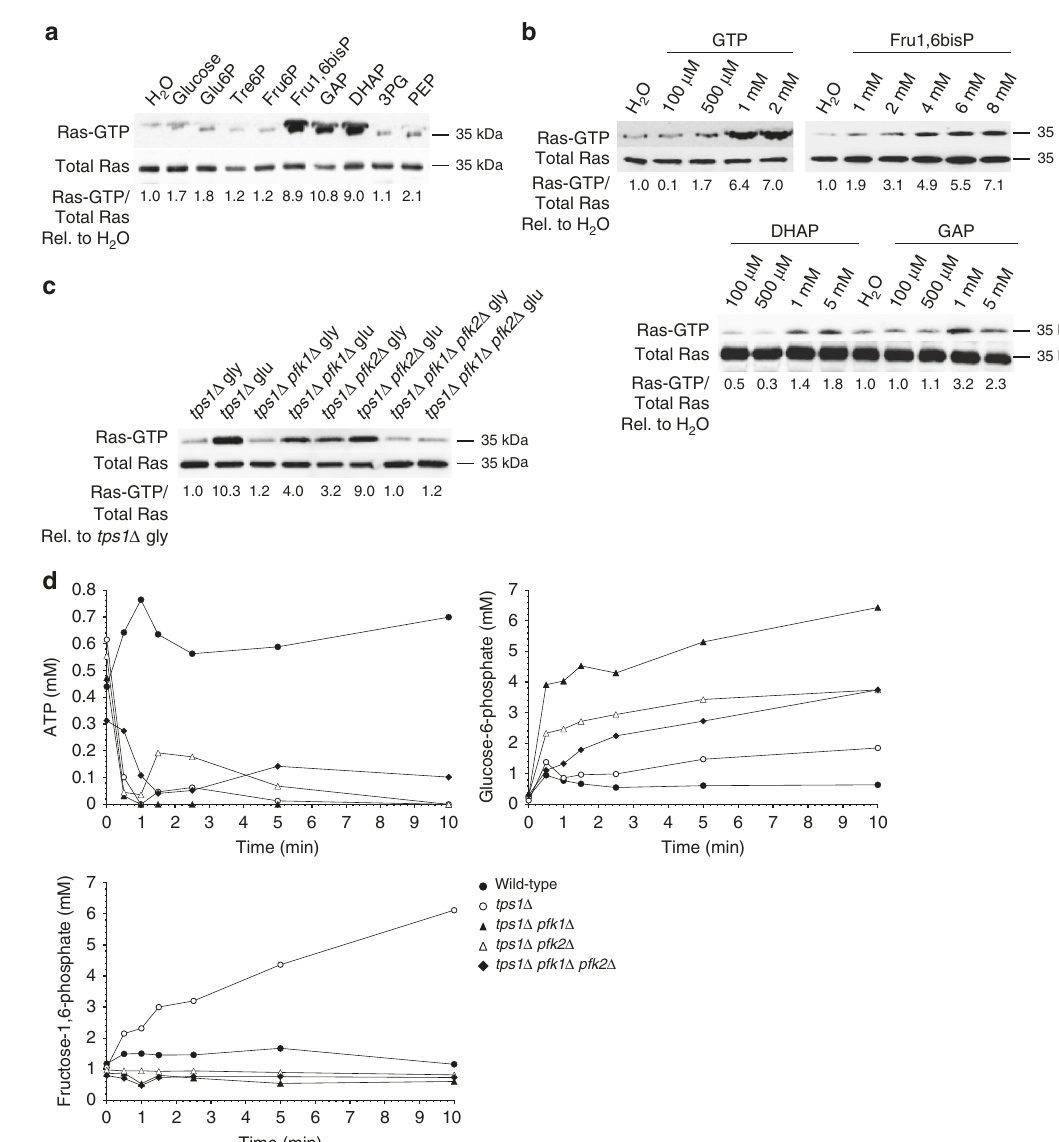
Fig. 4 Activation of Ras by Fru1,6bisP. a Ras-GTP level 3 min after addition of 5 mM of different glycolytic metabolites to permeabilized yeast spheroplasts. Glu6P, glucose-6-phosphate; Tre6P, trehalose-6-phosphate; Fru6P, fructose-6-phosphate; Fru1,6bisP, fructose-1,6-bisphosphate; DHAP, dihydroxyacetone phosphate; GAP, glyceraldehyde-3-phosphate; 3PG, 3-phosphoglycerate; PEP, phosphoenolpyruvate. Quanti fi cation of the signals as Ras-GTP level/total Ras level compared to the ratio for the water control set at 1.0. The values were determined through quanti fi cation by densitometry and are expressed as relative arbitrary units. b Activation of Ras in permeabilized spheroplasts with different concentrations of GTP, Fru1,6bisP, DHAP and GAP. Quanti fi cation of the signals as Ras-GTP level/total Ras level compared to the ratio for the water control set at 1.0. The values were determined through quanti fi cation by densitometry and are expressed as relative arbitrary units. c Ras-GTP level before and 10 min after addition of 100 mM glucose (glu) to cells grown on glycerol +2.5 mM glucose (gly). Quanti fi cation of the signals as Ras-GTP level/total Ras level compared to the ratio for tps1 Δ on glycerol set at 1.0. The values were determined through quanti fi cation by densitometry and are expressed as relative arbitrary units. d Intracellular ATP, Glu6P, and Fru1,6bisP concentration before and after addition of 100 mM glucose to cells grown in glycerol +2.5 mM